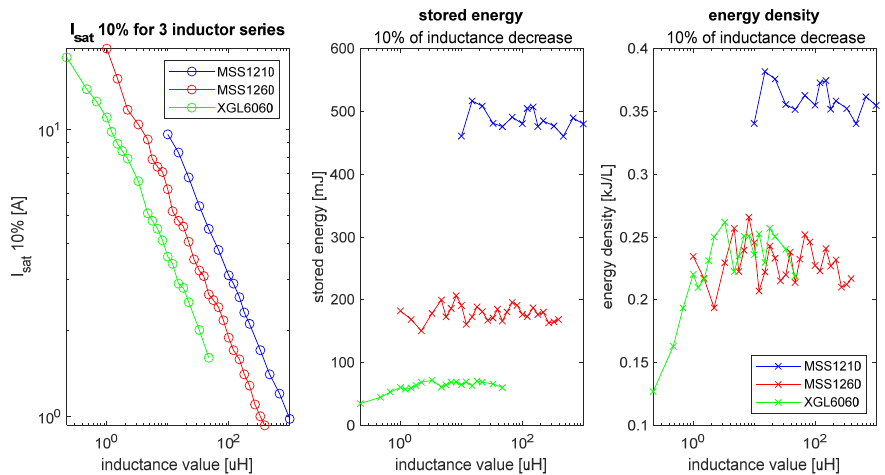
Figure 3. Saturation current (at 90% nominal inductor value) versus inductor value for three Coilcraft moulded inductor series. All data are extracted from [15–17].